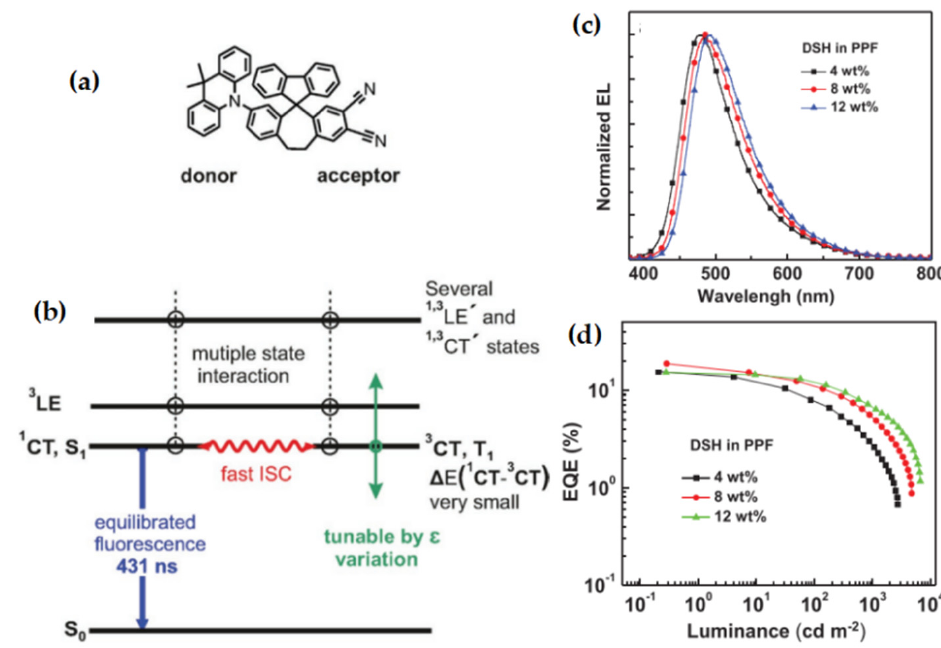
Figure 12. ( a ) Molecular structure of DSH; ( b ) simplified energy level diagram for the DSH molecule; ( c ) normalized EL spectra and ( d ) EQE–luminance characteristics of OLEDs with different concentrations of DSH. Reproduced with permission from Hartmut Yersin, Rafał Czerwieniec, Larisa Mataranga-Popa et al., “Eliminating the Reverse ISC Bottleneck of TADF Through Excited State Engineering and Environment-Tuning Toward State Resonance Leading to Mono-Exponential Sub- µ s Decay. High OLED External Quantum Efficiency Confirms Efficient Exciton Harvesting”; published by John Wiley and Sons , 2022